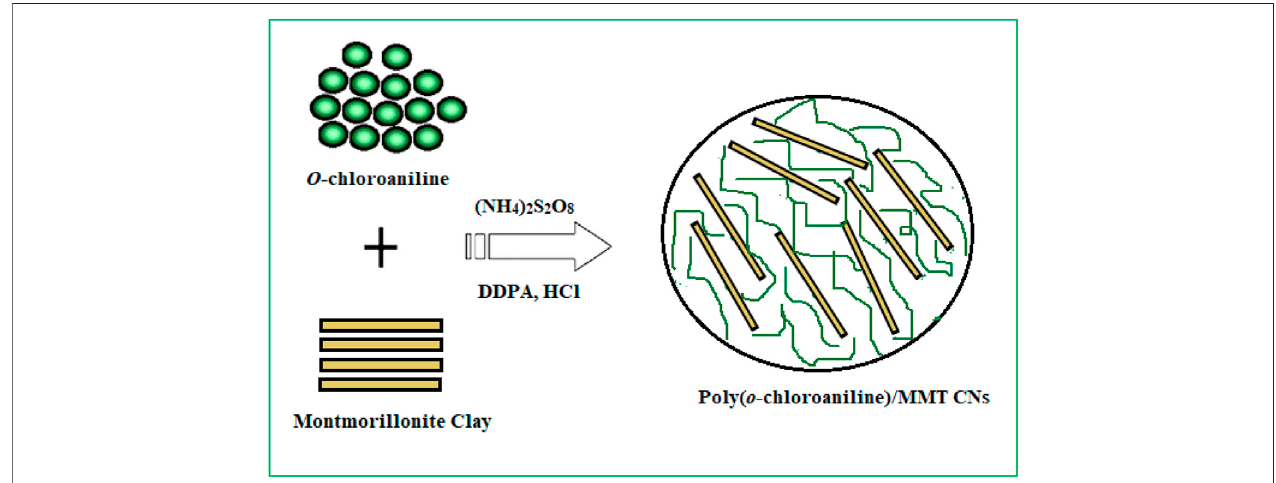
FIGURE 1 | Schematic illustration of the POC/MMT nanocomposite.